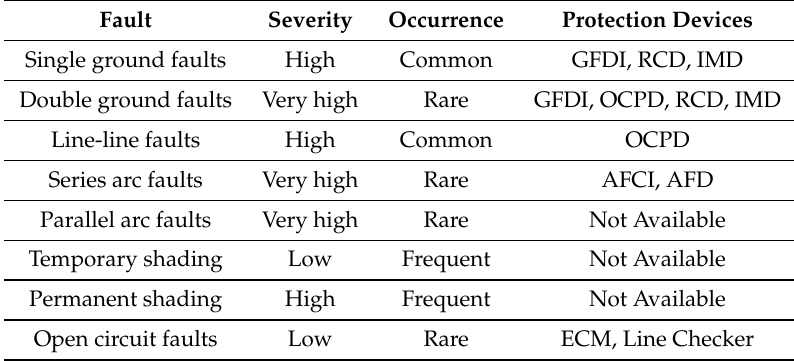
Table 11. Typical fault occurrences and respective protection/detection devices present in [107].